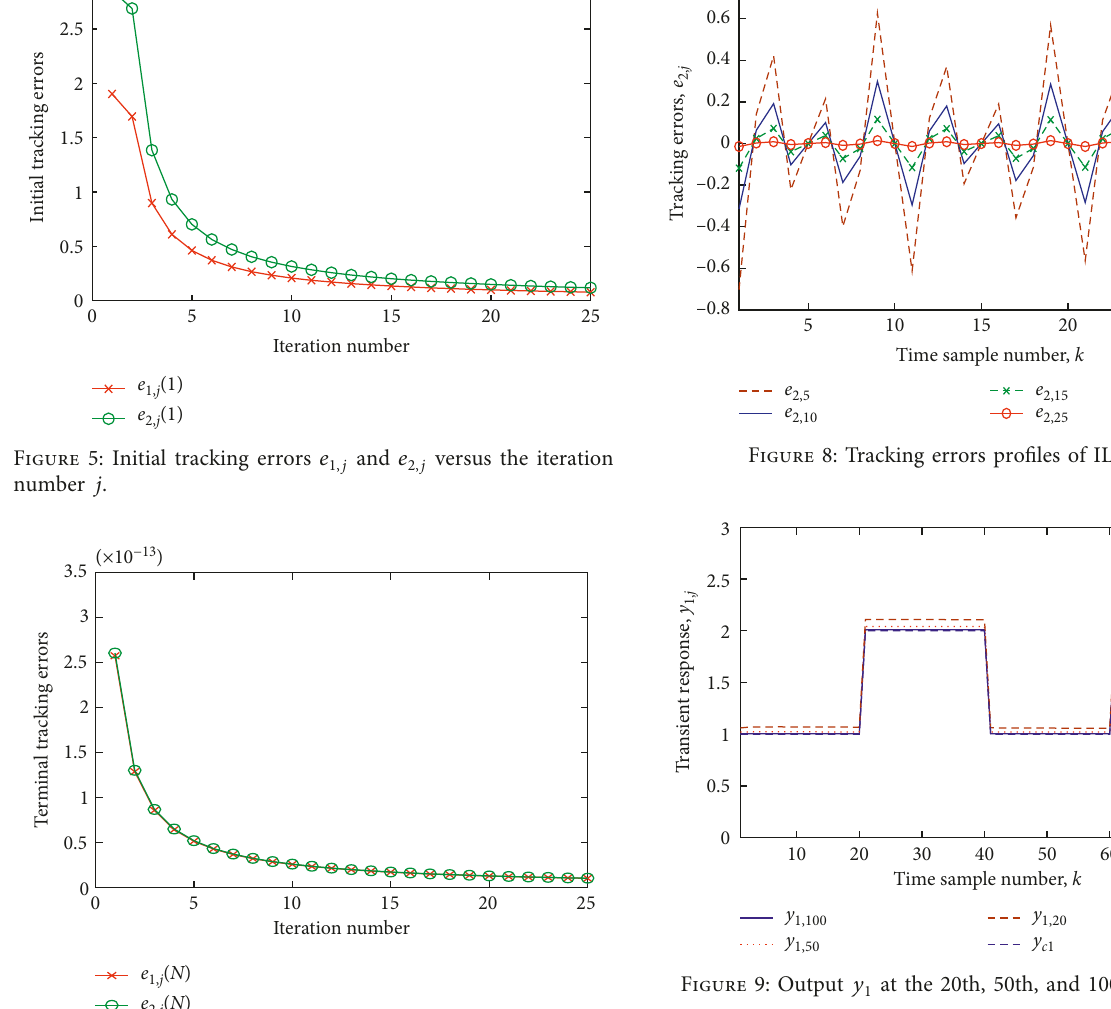
e 1 ,j and 2 ,j versus the iteration